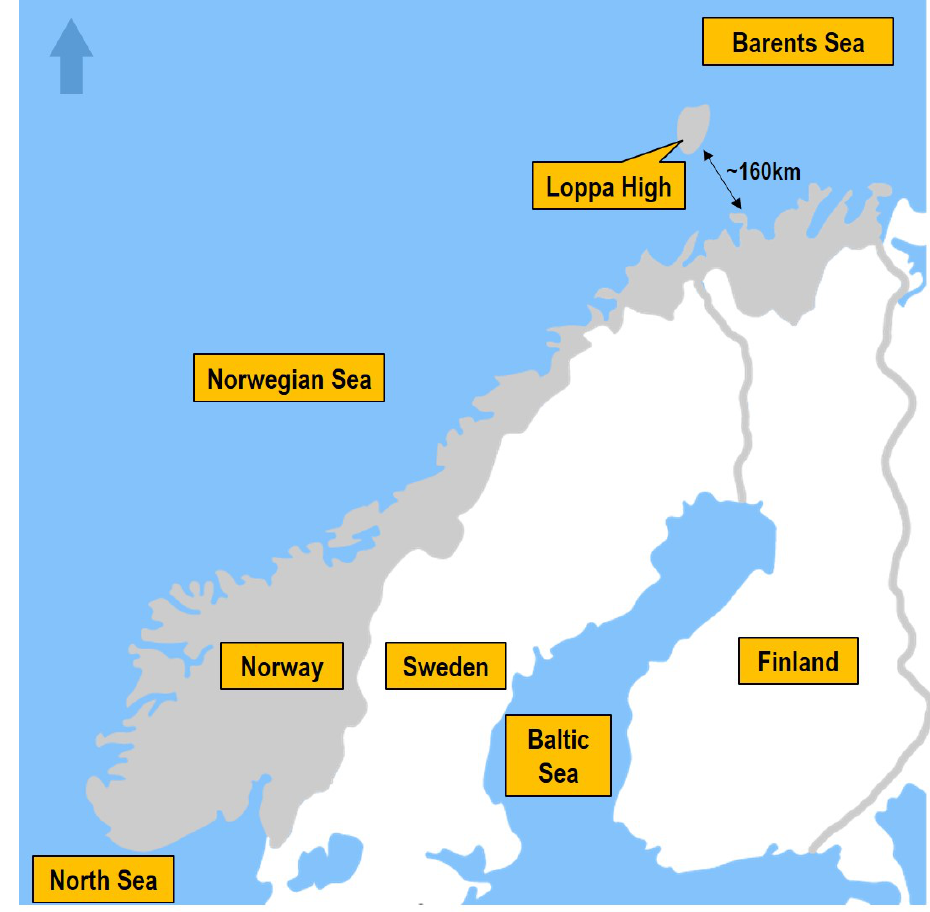
Figure 4. Barents Sea, Loppa High Region, Alta and Gohta